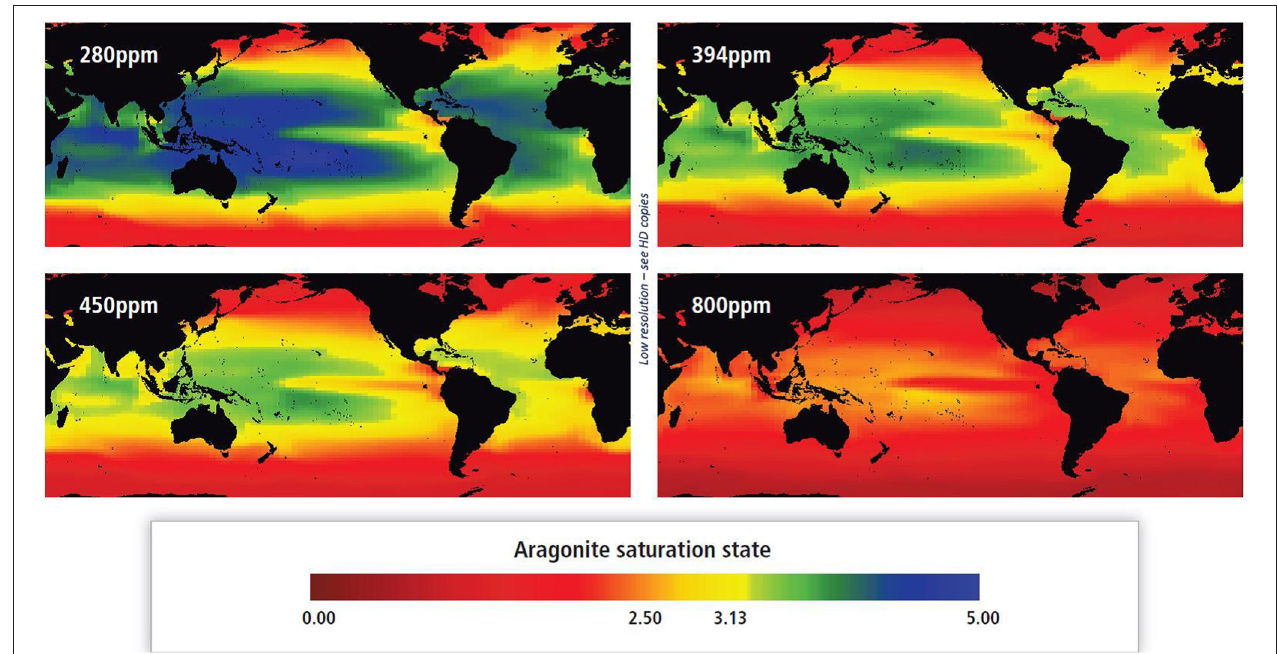
FIGURE 3 | Aragonite saturation state of the surface ocean simulated by the University of Victoria Earth System Model under different atmospheric concentrations of CO 2 . 280 ppm represents pre-industrial and 394 ppm levels in 2012. Four hundred and fifty ppm is projected to be reached during 2030s under Representative Concentration Pathway (RCP) 4.5, 6.0, and 8.5, and to approach, but not reach 450 ppm, during 2040s under RCP 2.6 (IPCC 2013). Eight hundred ppm is projected to be reached during 2080s under RCP 8.5 only. Fields are calculated from the model output of dissolved inorganic carbon concentration, alkalinity concentration, temperature, and salinity, together with the chemistry routine from the OCMIP-3 project. Modified from Figure SM30-2 in Hoegh-Guldberg et al. (2014; reprinted with permission of IPCC